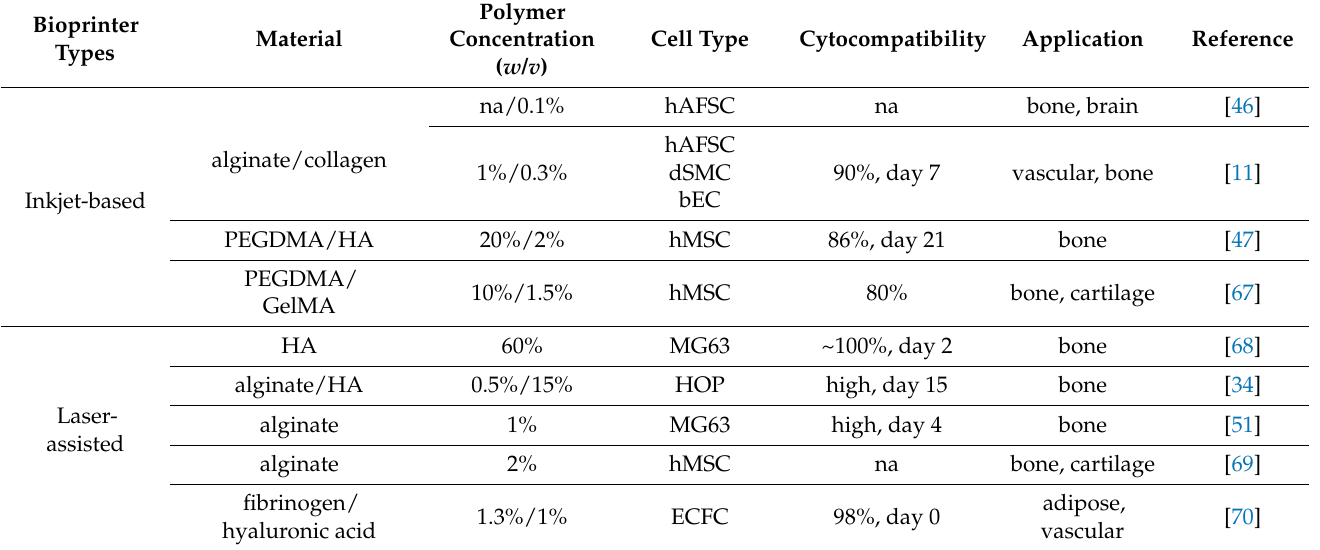
Table 2. A summary of outstanding recent bioprinting studies for human